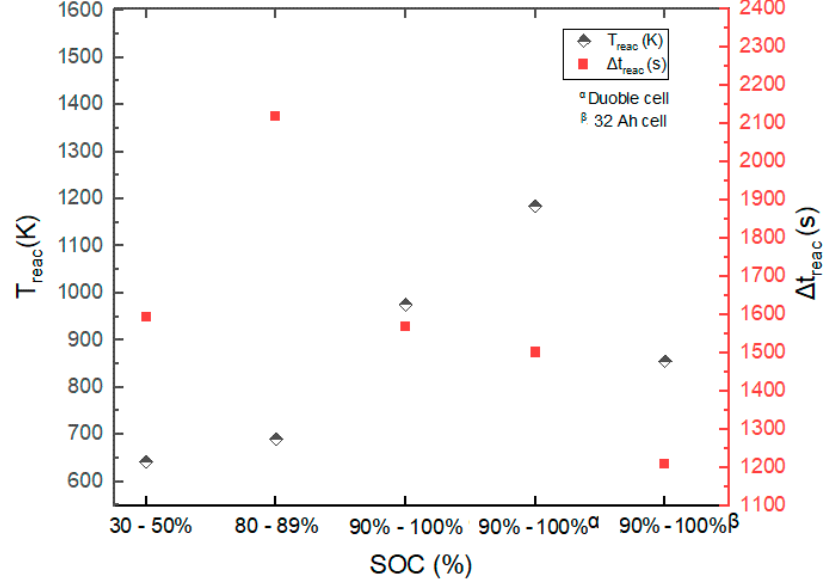
∆ t reac of LIBs tested in Series